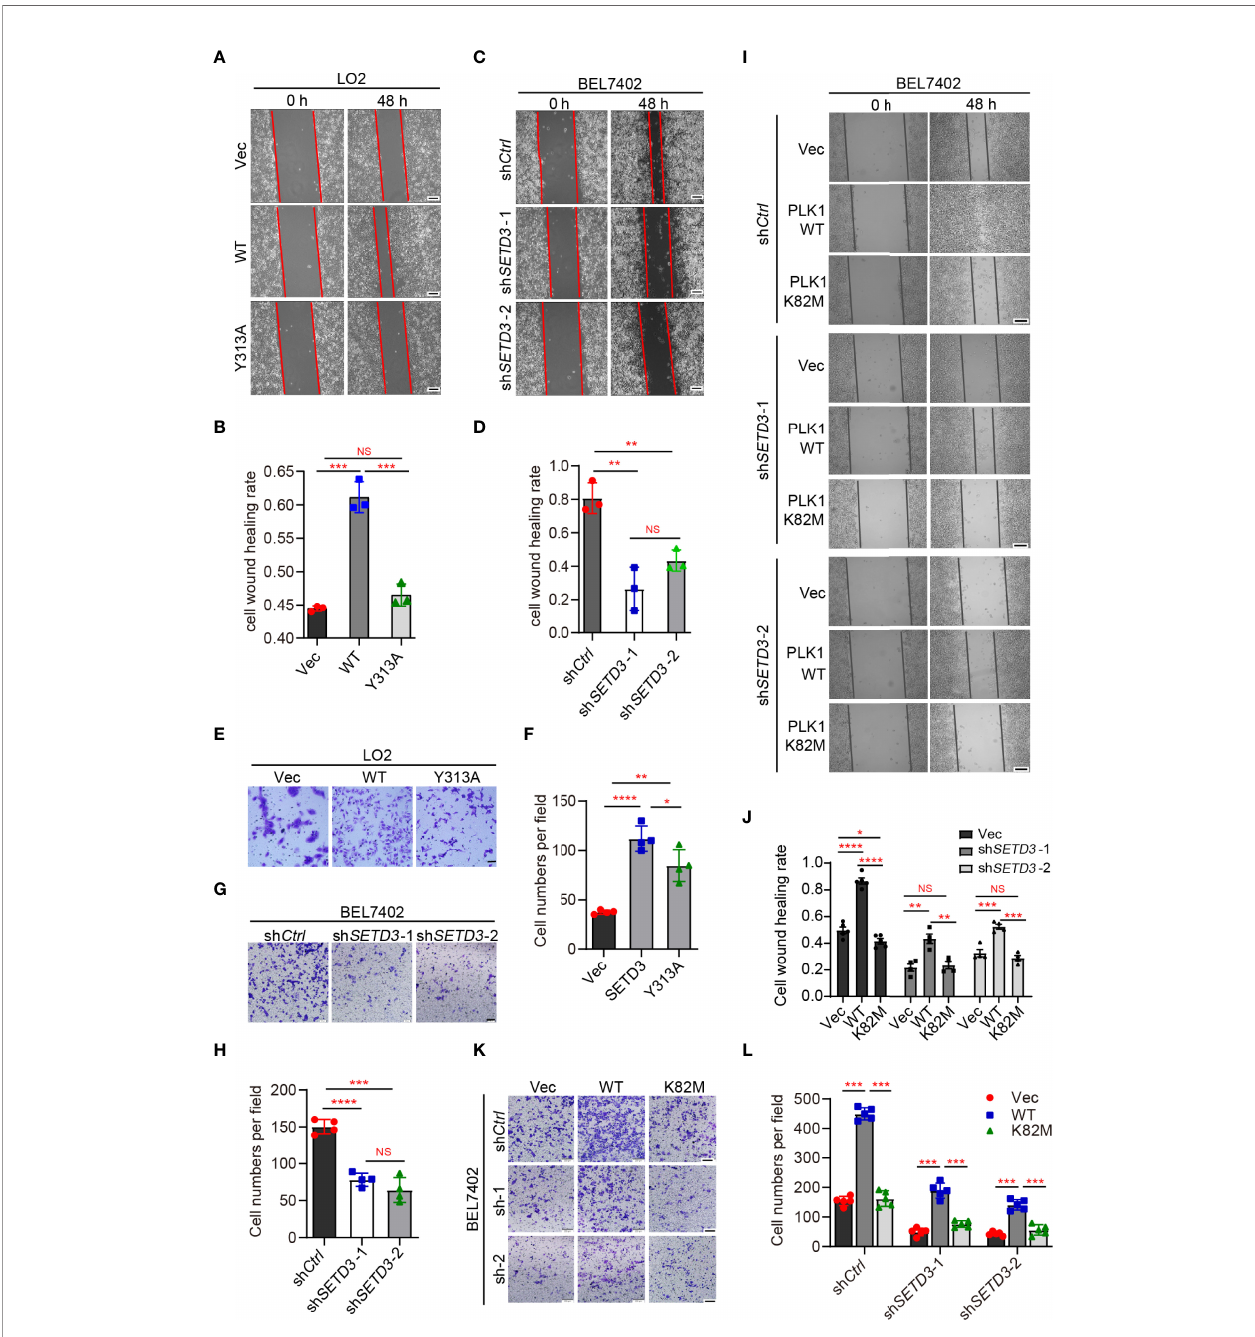
FIGURE 3 | PLK1 kinase activity is required for rescuing decreased cell migration by knockdown of SETD3 . (A – D) Examine cell migration in LO2 cells overexpressed with either WT or Y313A mutant of SETD3 (A, B) or in BEL7402 cells transfected with sh SETD3 construct (C, D) . Representative images at the indicated time points were present in panels (A, C) , and quantitative data from three independent replicates are shown in panel (B) or (D) , respectively. Scale bar , 500 m m. (E – H) Transwell assays were performed in the cells transfected with the indicated constructs. Representative images are present in panels (E, G) , and quantitative data from three independent replicates are shown in panel (F) or (H) , respectively. (I – L) Wound healing and cell migration assays were performed in sh SETD3 BEL7402 cells transfected with WT or K82M mutant of PLK1. Representative images are presented in panel (I) or (K) , and quantitative data from three independent replicates are shown in panel (J) or (L) . Scale bar , 500 m m. Data are presented as mean ± SD. NS, not signi fi cant; * p < 0.05; ** p < 0.01; *** p < 0.001; **** p <